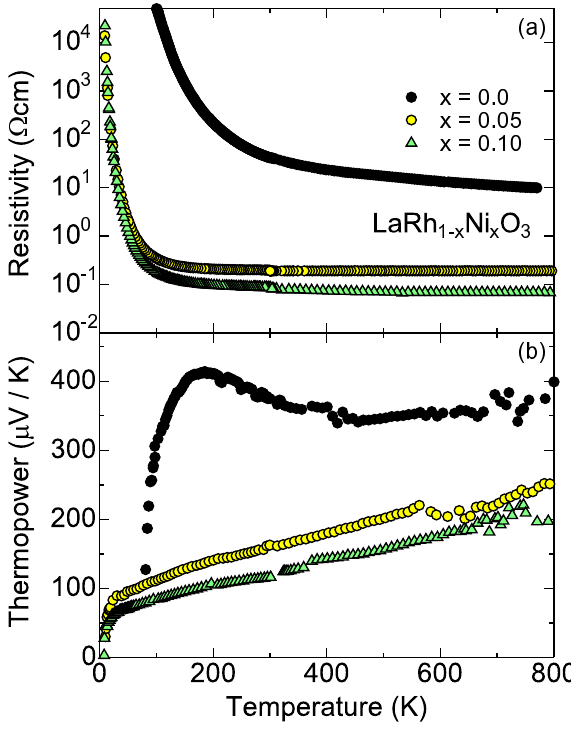
Ni O [51]. (a) Resistivity and (b) 1 ¡ x x 3